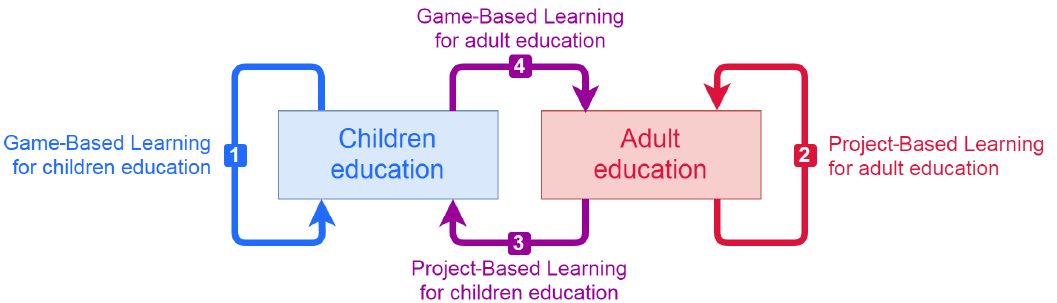
Figure 1. Project-Based Learning and Game-Based Learning